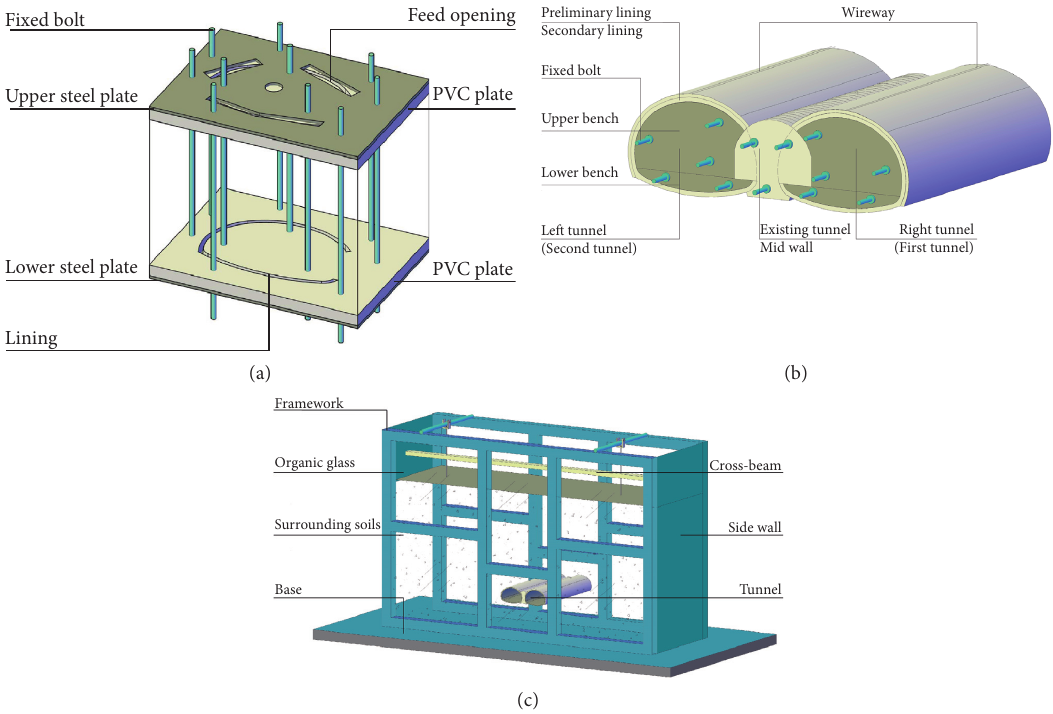
Figure 1: Tunnel excavation model test system. (a) Schematic of structure pouring mould. (b) Schematic of preexcavation model. (c) Schematic of model test